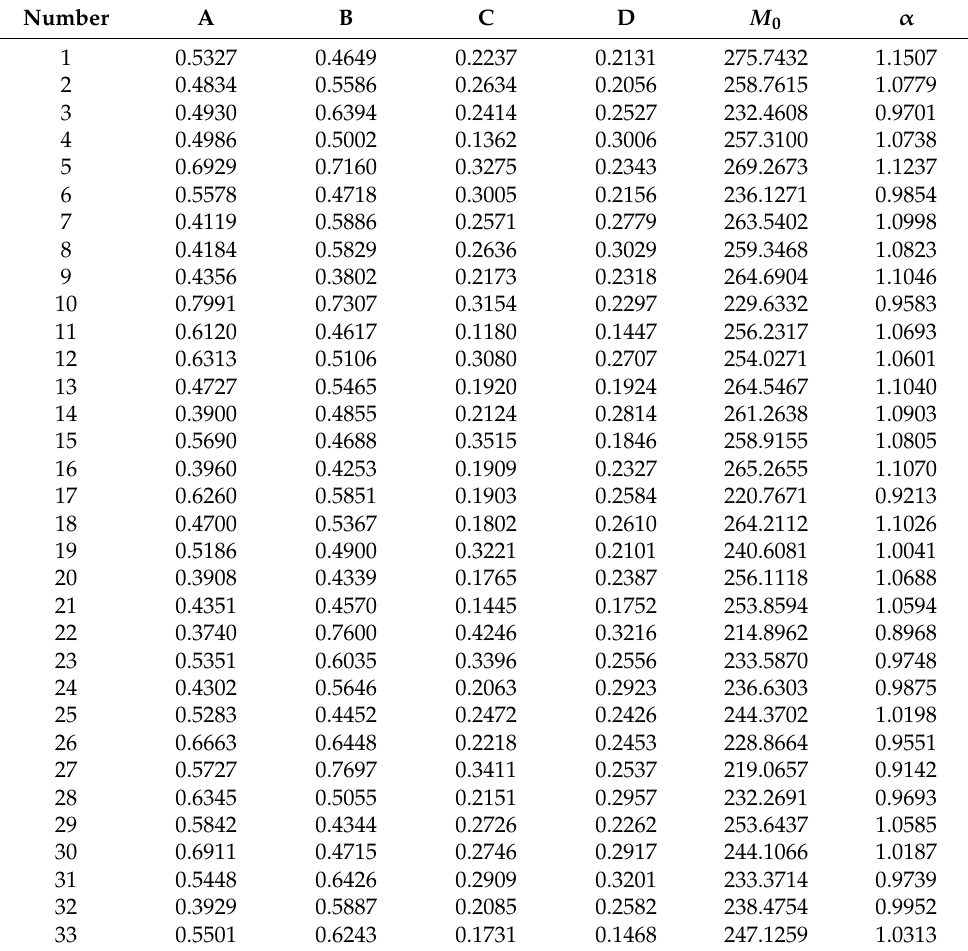
Table 3. Dataset of the concrete piston life